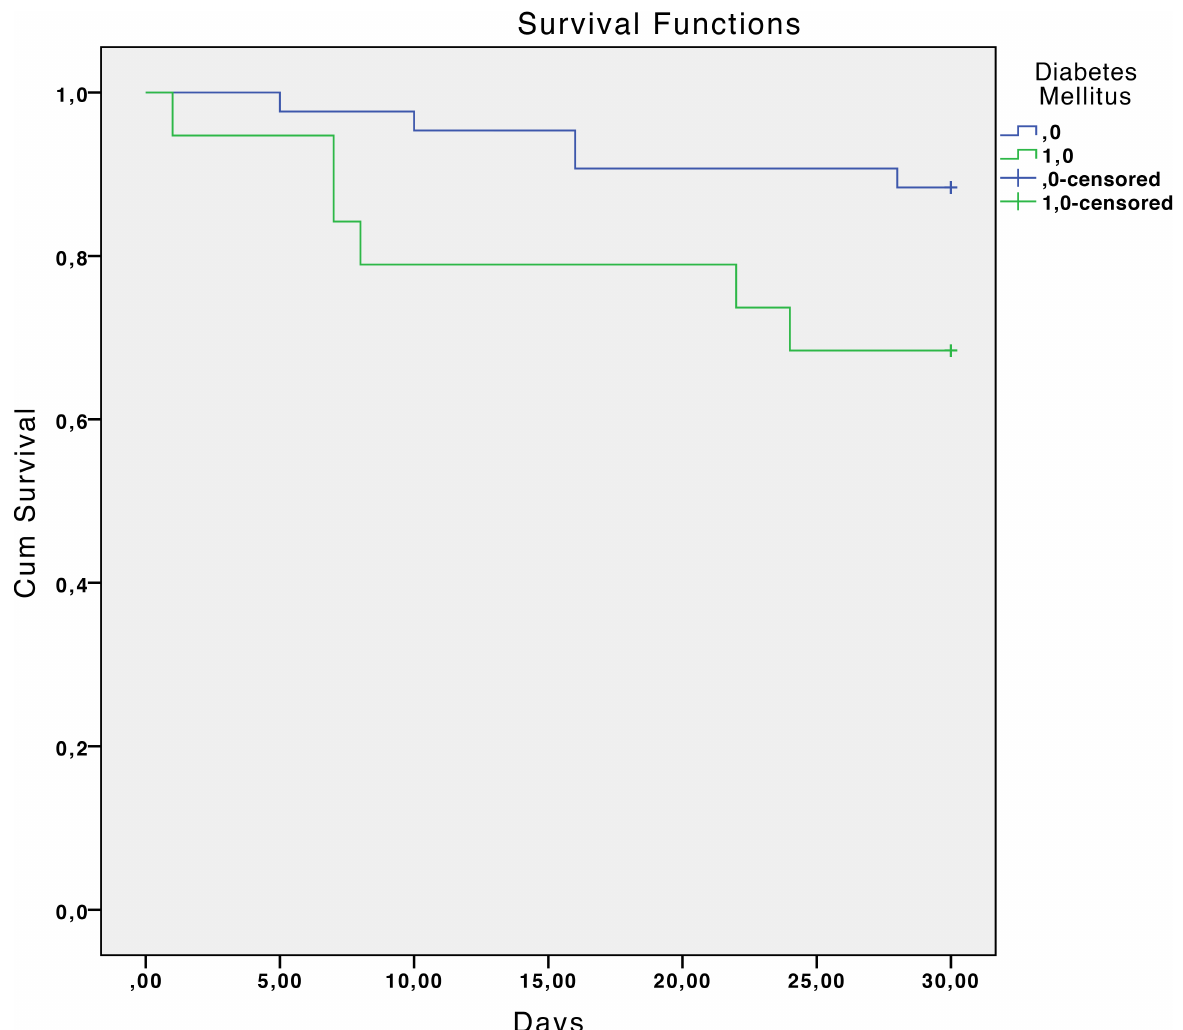
Fig 2. Kaplan-Meier 30-day survival curve according to diabetes mellitus. P = 0.04 (log-ranktest).